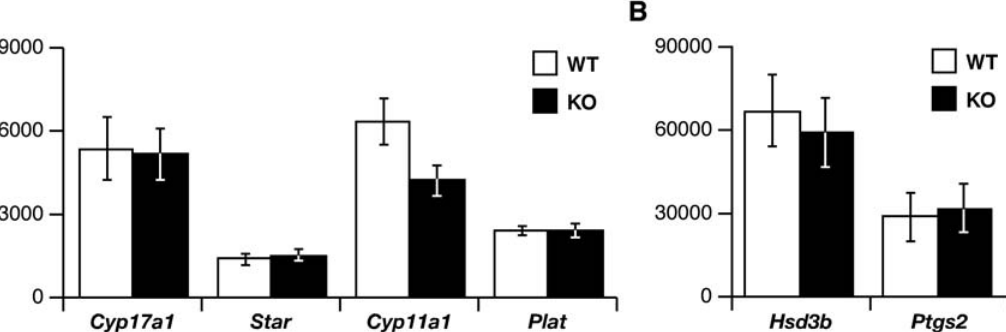
Figure 6. Normal gene expression pattern in Cebpd-deficient ovaries. Phosphorimage quantification of Northern blot analyses for the indicated genes of whole ovary total RNA from 5 week-old Cebpd null mice (KO) and litter mate controls (WT) treated for 2 days with PMSG followed by hCG for 4 hours. Expression levels were normalized to cyclophilin ( Ppi ) expression (a.u.=arbitrary units; means 6 SEM). Panel A: n=6 WT, 8 KO; Panel B: n=4 WT, 4 KO.